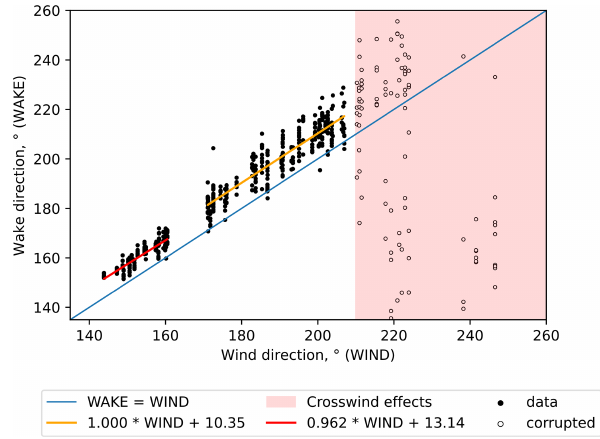
Figure 23. Comparison between reference wind direction (WIND) and estimated wake direction